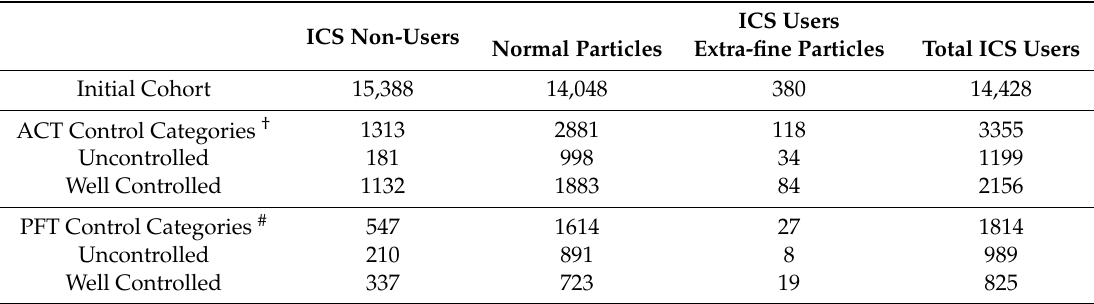
Table 2. Number of ICS users by particle size and asthma control